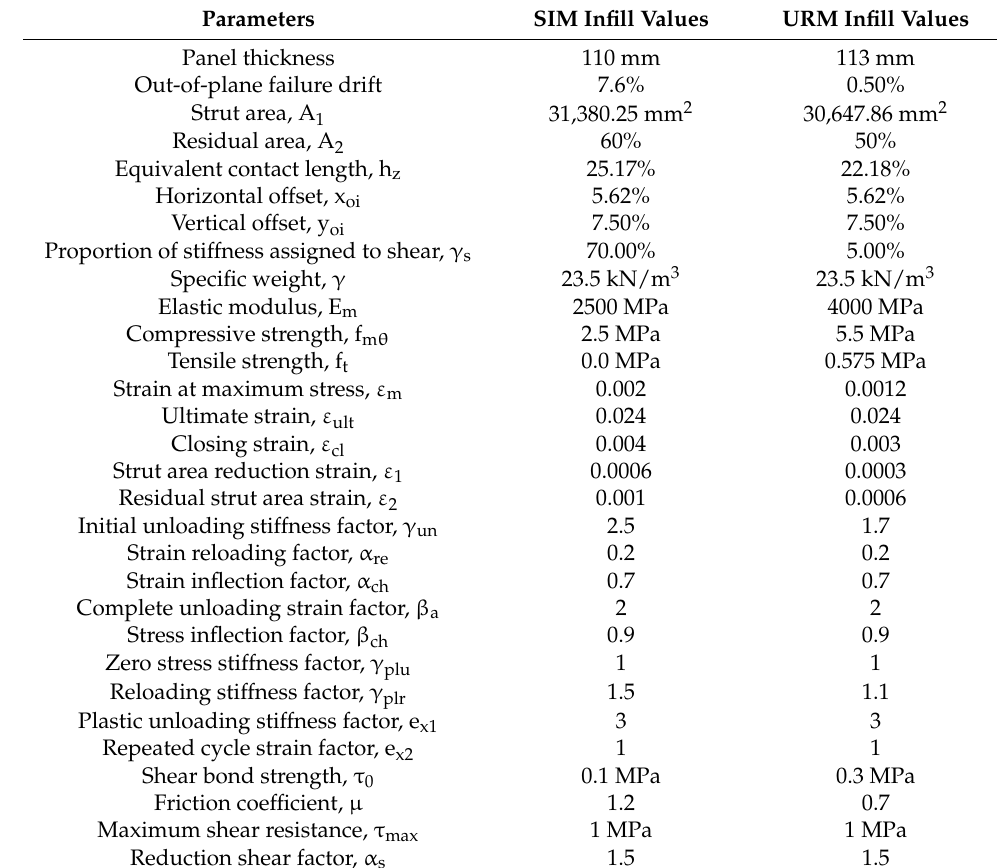
Table 2. Input parameters of SIM infill and URM infill panel